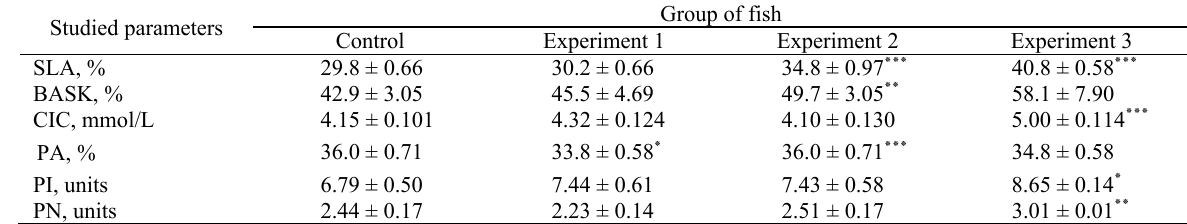
Parameters of nonspecific resistance of age-1+ carp under the effect of the prebiotic additive ( М ± m, n = 5) Studied